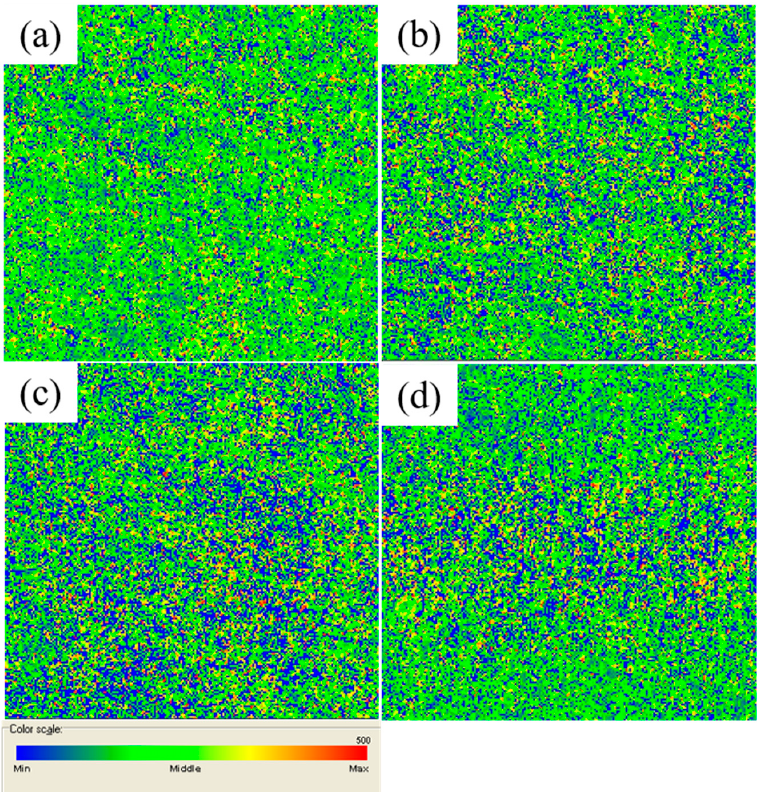
Figure 9. The KAM of longitudinal section for the LPBF-processed parts: ( a ) CCM, ( b ) CCM@1Al 2 O 3 , ( c ) CCM@1.5Al 2 O 3 and ( d ) CCM@2Al 2 O 3 .